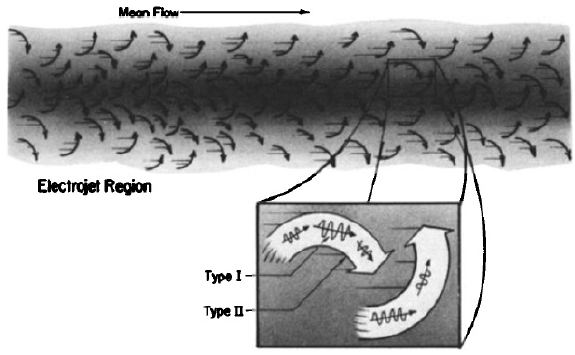
Fig. 12. A sketch of the irregular electron velocity field in the elec- trojet. Large scale instabilities produce E × B velocity perturbations comparable to the mean values. The “local” velocities then drive small scale ion-acoustic instabilities, even in the vertical direction (from Farley and Balsley,